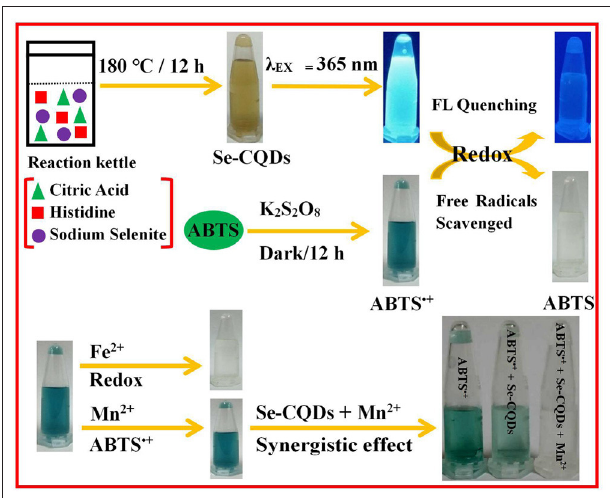
SCHEME 1 | The preparation of Se-CQDs and ABTS •+ and the colorimetric detection of Mn(II) by Se-CQDs + ABTS •+ .